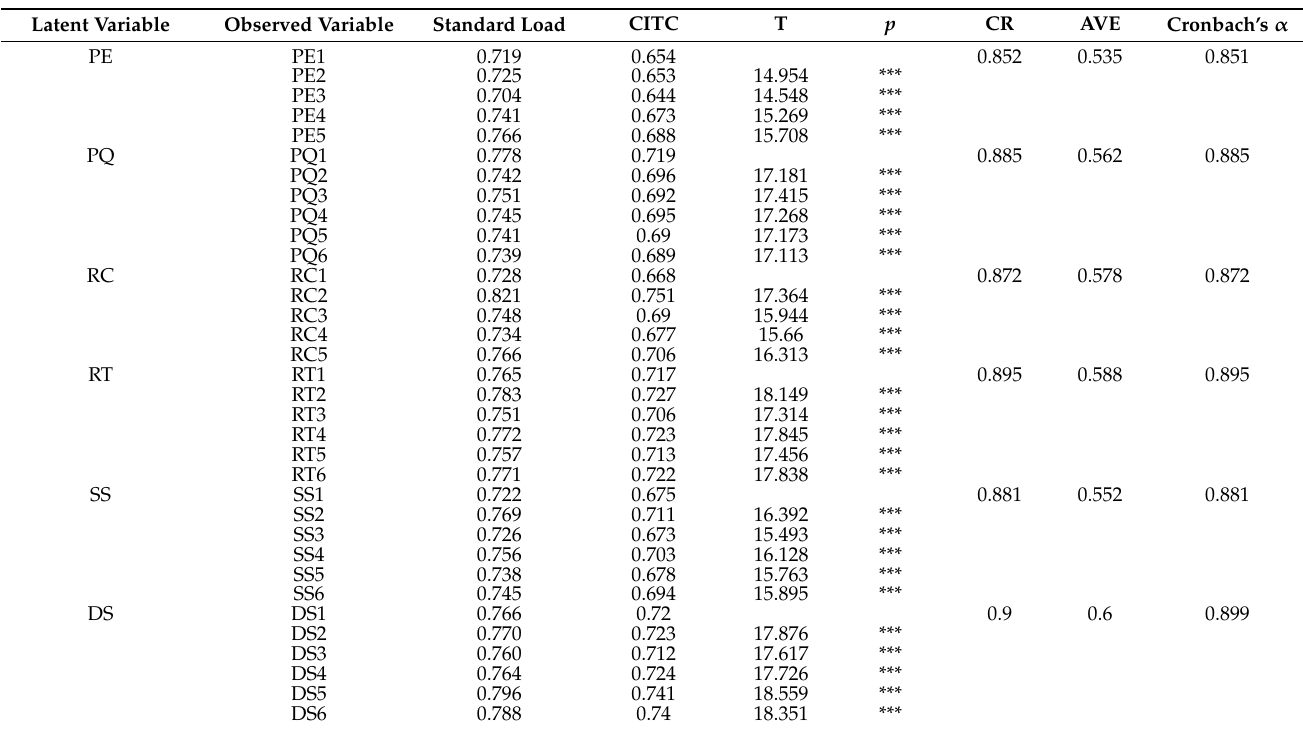
Table 3. The main information from exploratory factor analysis (EFA) and confirmatory factor analysis (CFA). Latent